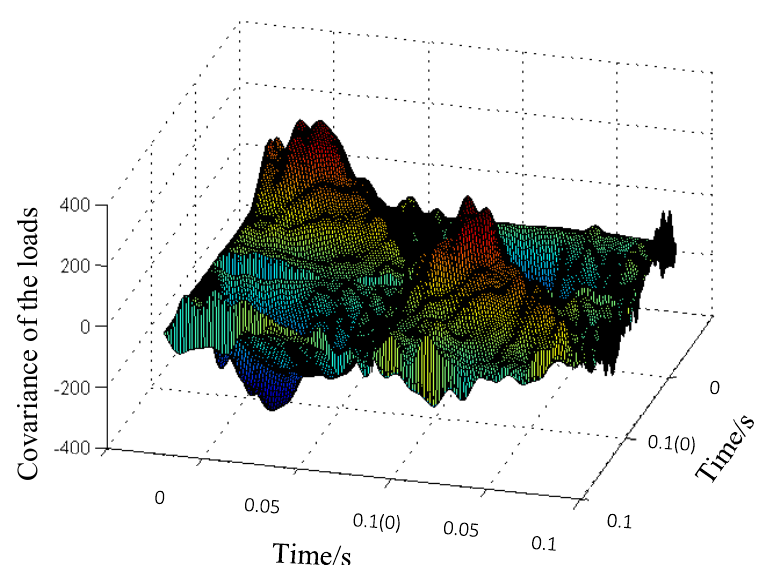
Figure 10. The identified covariance matrix of the loads.